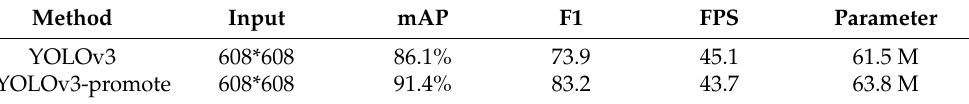
Table 1. Performance comparison of algorithms.